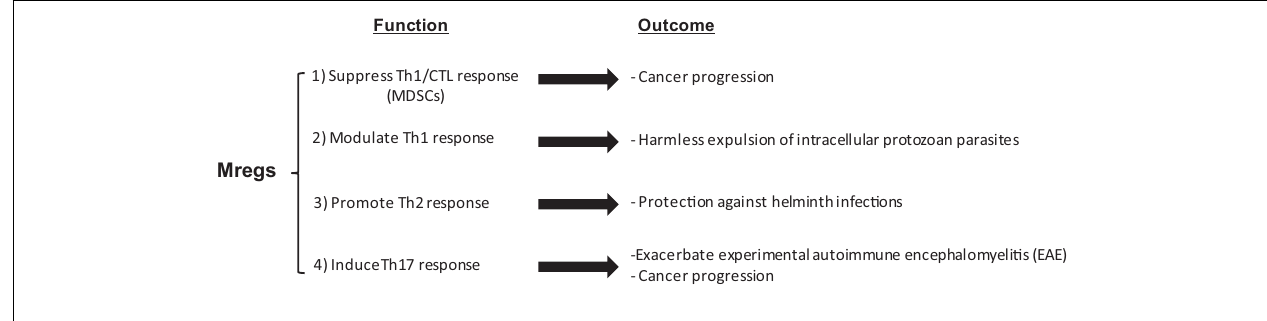
FIGURE 1 |The multifaceted function of Mregs